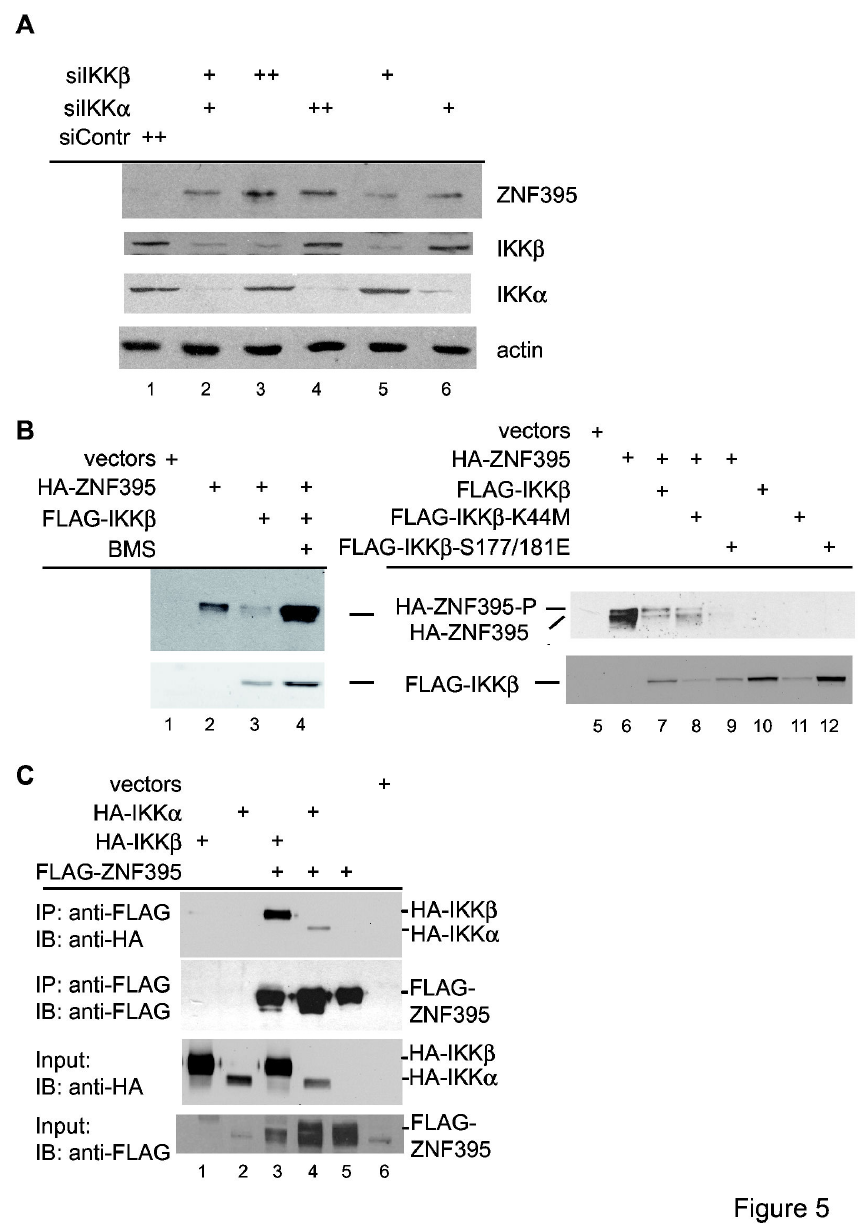
Figure 5. IKK targets ZNF395 to degradation. ( A ) Analysis of extracts of U87-MG cells that were transfected with 500pmol control siRNA (siContr) (lane 1), with a mixture of 250pmol of siIKKα and siIKKβ each (lane 2), with 500 (++) pmol siIKKβ or siIKKα (lanes 3 and 4), and with 250pmol (+) siIKKβ (lane 5) or siIKKα (lane 6) (in both cases 250pmol siContr was included to keep the total amount of siRNA constant). Total cell extracts were prepared 48h later and analyzed for the expression of ZNF395, IKKα, IKKβ and actin with specific antibodies by IB. ( B ) In lanes 1-4, extracts of RTS3b cells that were transiently transfected with expression vectors for HA-ZNF395 and FLAG-IKKβ were used. Where indicated, BMS-345541 was added to the cells 24h prior to harvesting. In lanes 5-12, the vector for HA-tagged ZNF395 or the empty vector was co-transfected with the plasmids encoding wt FLAG-IKKβ, FLAG-IKKβ-K44M, a kinase inactive mutant, FLAG-IKKβ-S177/181E, a constitutive active mutant, as indicated. ZNF395 expression was monitored in an IB developed with the anti-HA-antibody, while the expression of IKKβ proteins was detected by the FLAG antibody. ( C ) Co-immunoprecipitation. C33A cells were transfected with expression vectors for FLAG-ZNF395, HA-IKKα or HA-IKKβ in various combinations, as indicated. Immunoprecipitations were performed with M2-FLAG agarose and bound proteins were detected by an IB developed with the anti-HA and anti-FLAG antibody. 50µg of total extracts were used as input control to monitor the presence of ZNF395, IKKα and IKKβ in the extracts used for the co-immunoprecipitation, shown in the two blots at the bottom. doi: 10.1371/journal.pone.0074911.g005 PLOS ONE |